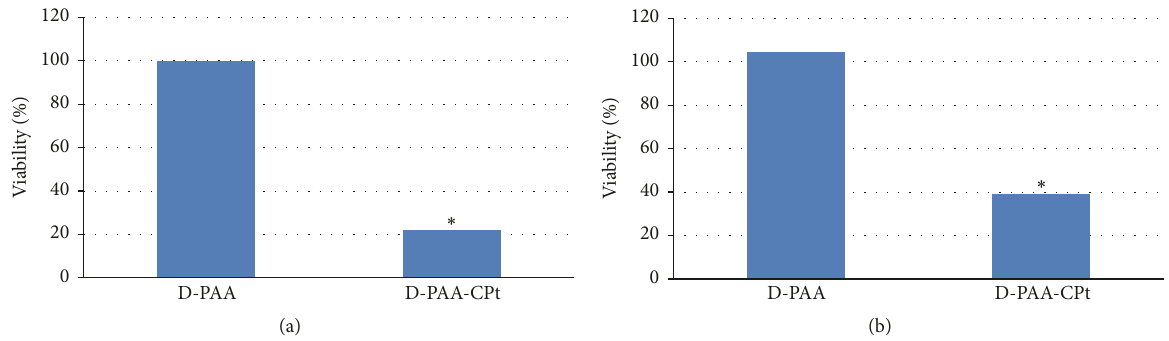
Figure 5: The percentage of viable U-937 (a) and K-562 (b) cells after incubation with the nanoparticles D-g-PAA(PE) and D-g- PAA(PE)/cisplatin assessed by Trypan Blue staining. The nanoparticles were added at concentration of 5 𝜇 g/mL D-g-PAA(PE)/cisplatin. Data are means ± SD; ∗ significant difference between two groups ( 𝑃 < 0.05